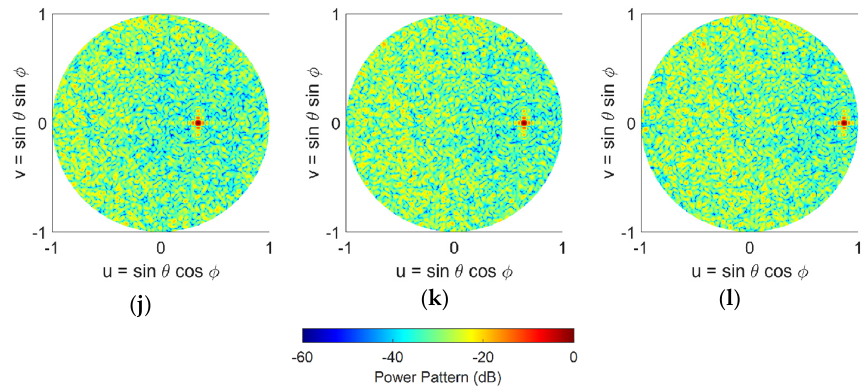
Figure 9. Normalized power patterns of the antenna arrays in the u-v space scanned along the elevation plane in ϕ = 0° direction with different element distributions: ( a ) uniform (20° scan), ( b ) uniform (40° scan), ( c ) uniform (60° scan), ( d ) random (20° scan), ( e ) random (40° scan), ( f ) random (60° scan), ( g ) Halton (20° scan), ( h ) Halton (40° scan), ( i ) Halton (60° scan), ( j ) Poisson disk (20° scan), ( k ) Poisson disk (40° scan), ( l ) Poisson disk (60° scan). The Halton sampling uses prime bases of 2 and 7.